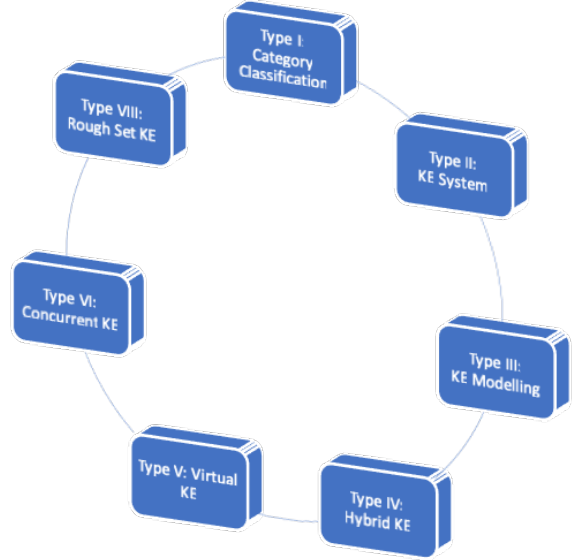
Figure 1. Types of Kansei engineering